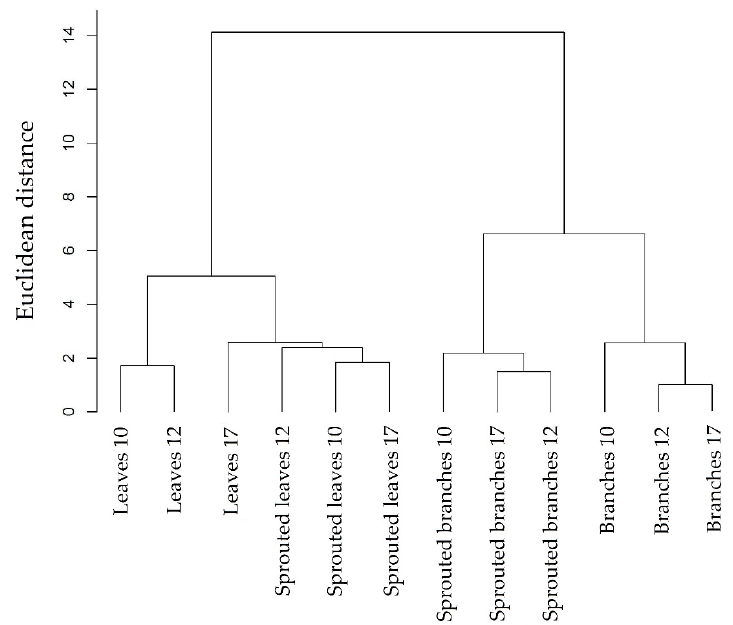
Figure A5. Box plot and p values of paired mean tests comparing branch chemical attributes data for “reference” and “regrowth” material collected by sequential management of above ground rosewood mass in the three study areas. ( a ) Nitrogen; ( b ) Phosphorus; ( c ) Potassium; ( d ) Calcium; ( e ) Magnesium; ( f ) Iron; ( g ) Zinc and; ( h ) Manganese.